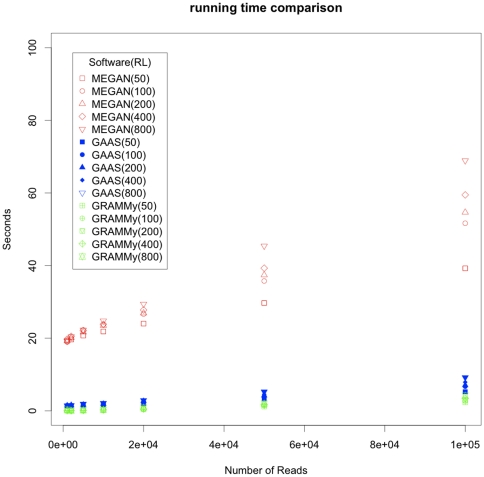
Running time comparison.GRAMMy is the fastest in all cases as compared to MEGAN and GAAS in processing time. The BLAT mapping time is excluded for all compared tools.